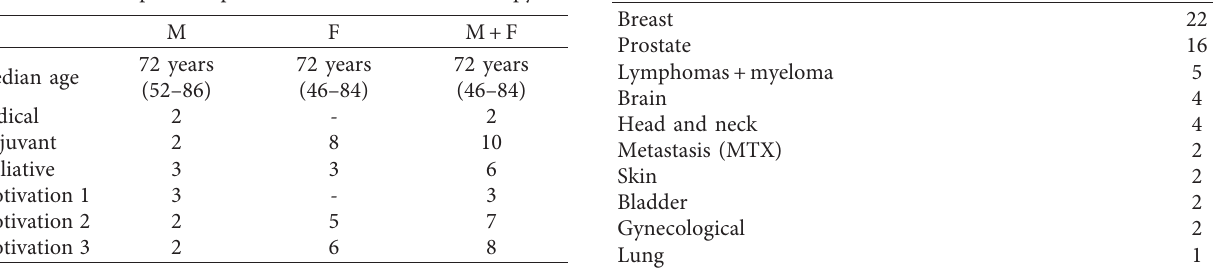
Table 2: Description of patients who refused radiotherapy. Table 4: Oncologic diagnosis of patients.